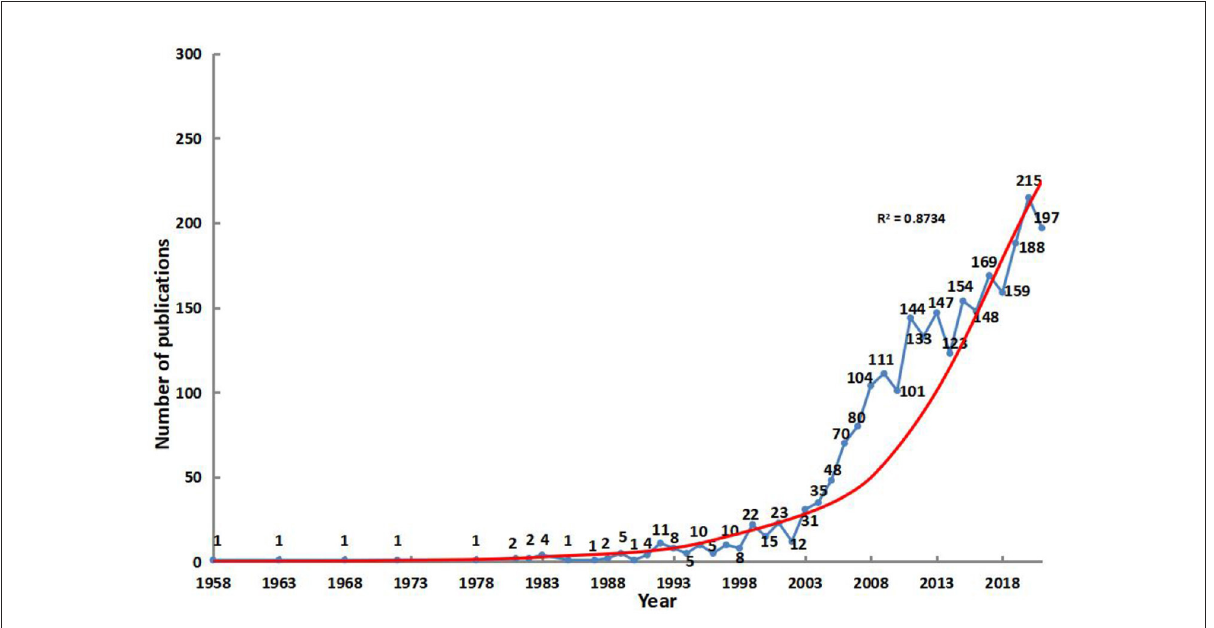
FIGURE2 Literature on WLOCA published from